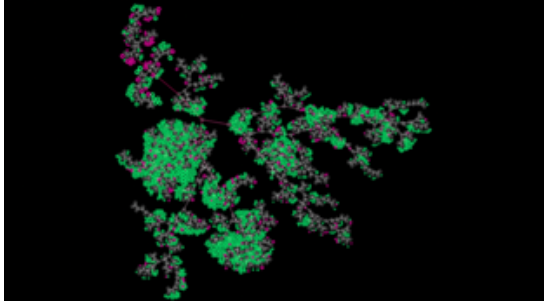
Figure 12 | The algorithm mapped out spatially showing all possible pathways. Gravity and spring physics simulate an organic aesthetic.